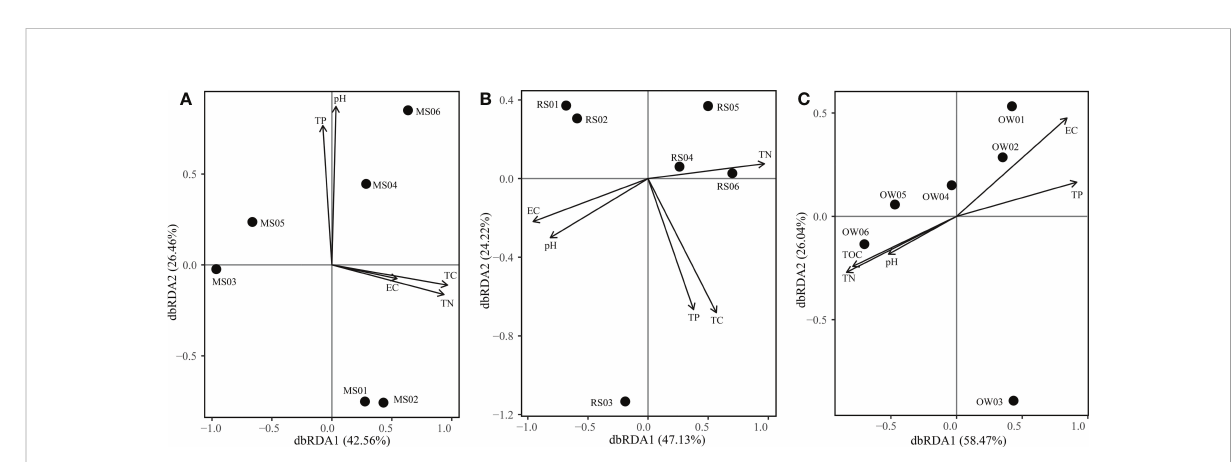
FIGURE 7 Distance-based redundancy analyses (RDA) of bacterial communities in mangrove soil (A) , river sediment (B) and overlying water (C) .